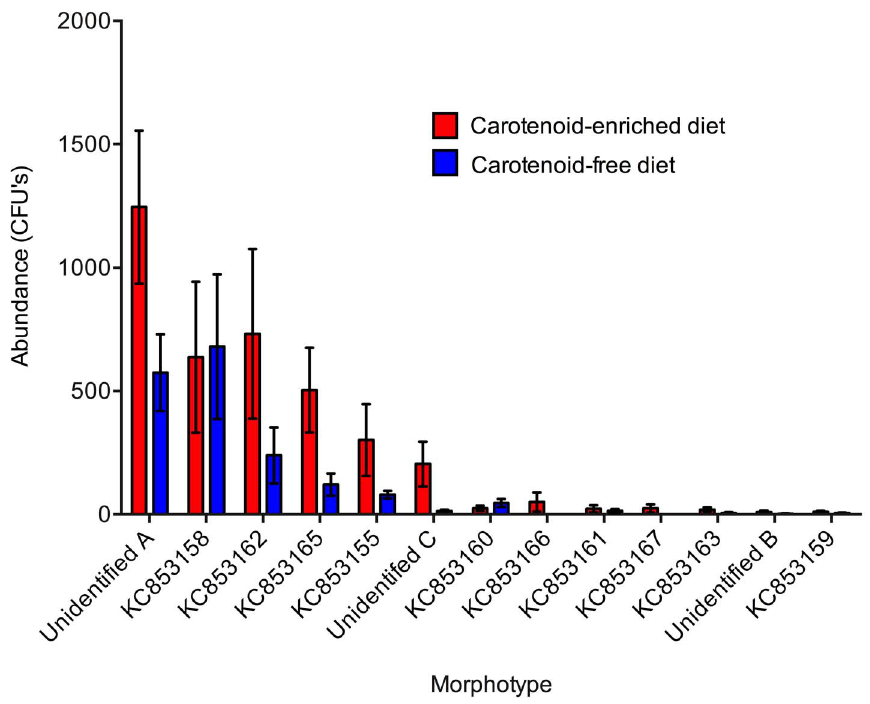
Figure 3. Abundance of each bacterial morphotype (number of colony forming units (CFUs) isolated from each individual) isolated from the skin of Agalychniscallidryas fed on a carotenoid-enriched and carotenoid-free diet. Morphotype identities are indicated by GenBank accession number; see Table 1 for details. Error bars show 6 1 S.E.M.